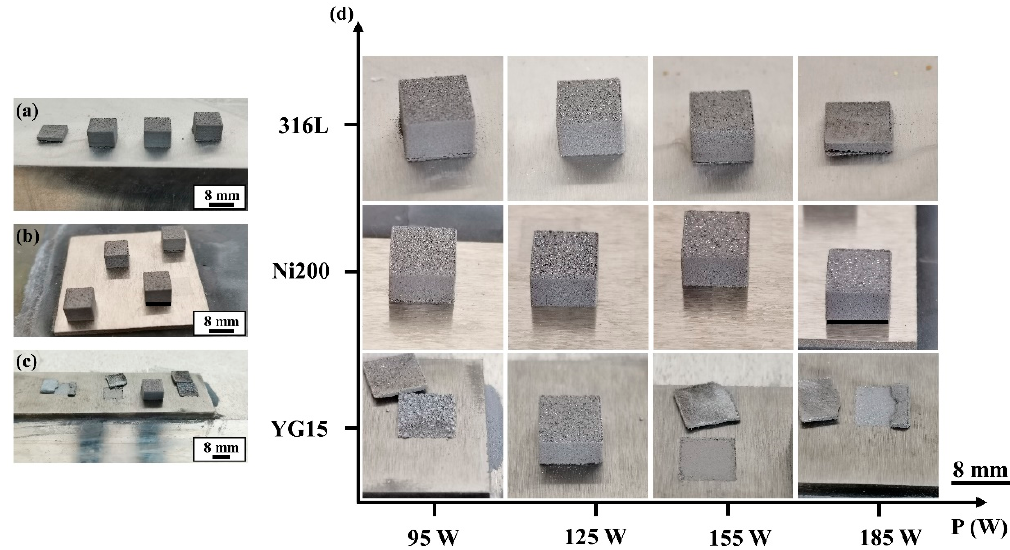
Figure 9. The blocks formed on different substrates: ( a ) 316L substrate; ( b ) Ni200 substrate; ( c ) YG15 substrate; ( d ) high-magnification picture of blocks.